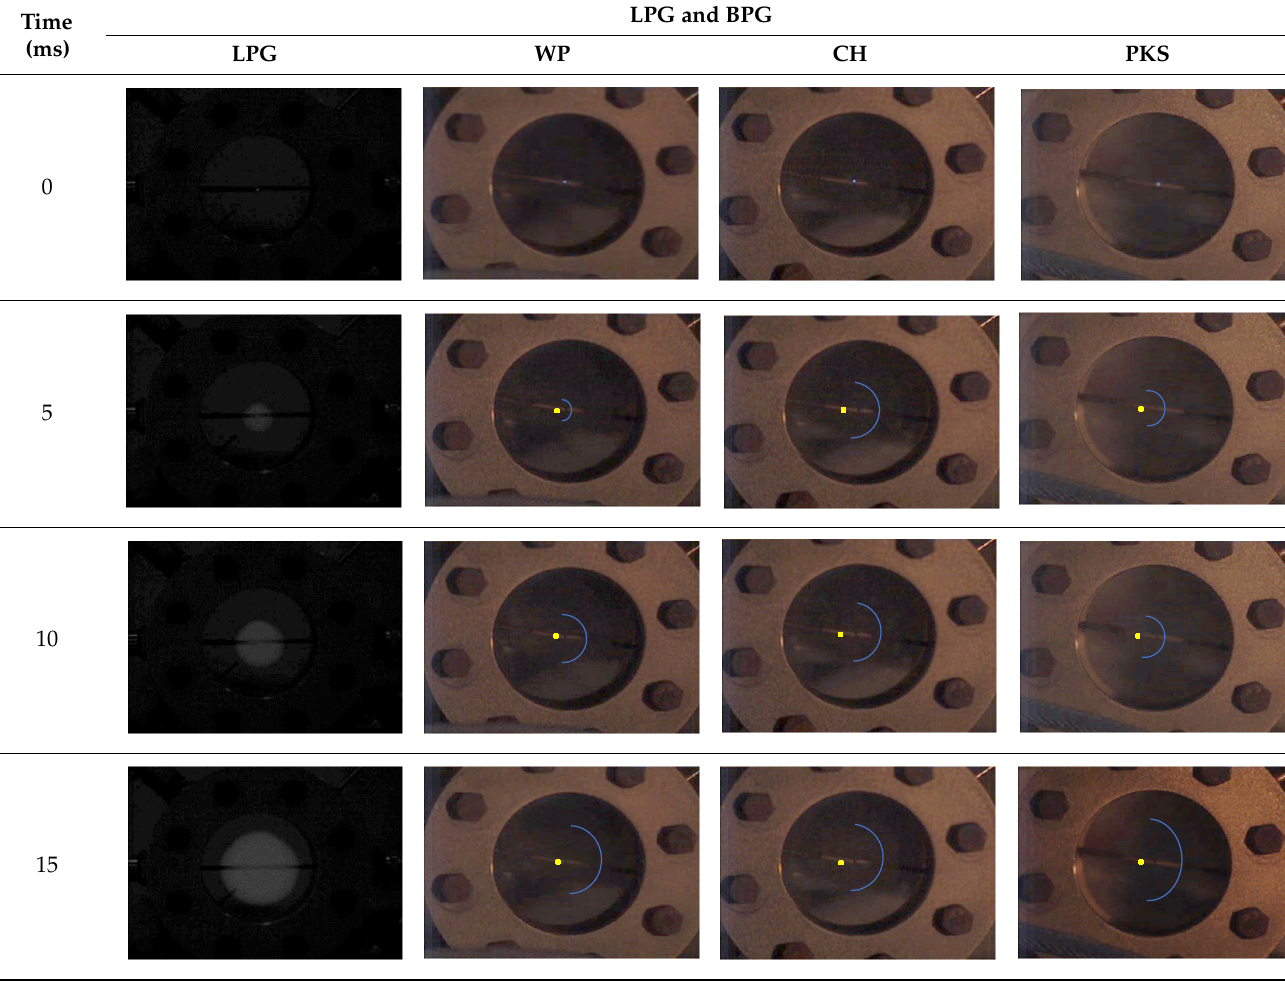
Table 4. Images of flame propagation of LPG and BPG.